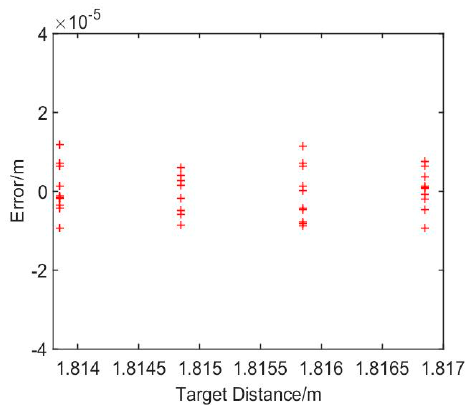
Figure 11. The results of different distances after dispersion compensation.